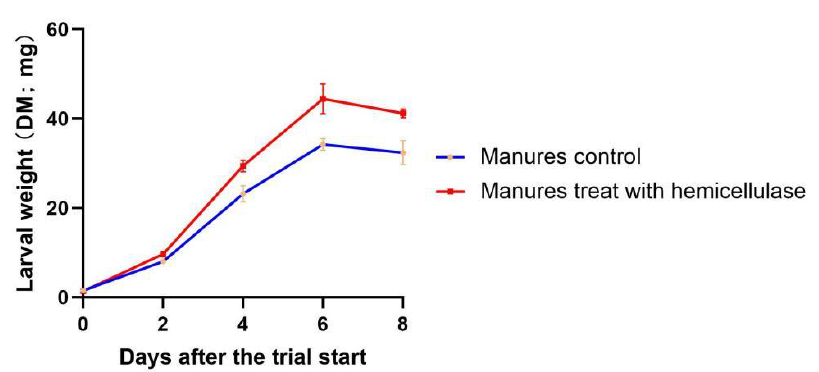
Figure 3. Dry weight of black soldier fly larvae fed hemicellulase-treated manure and control ma- 238 nure.